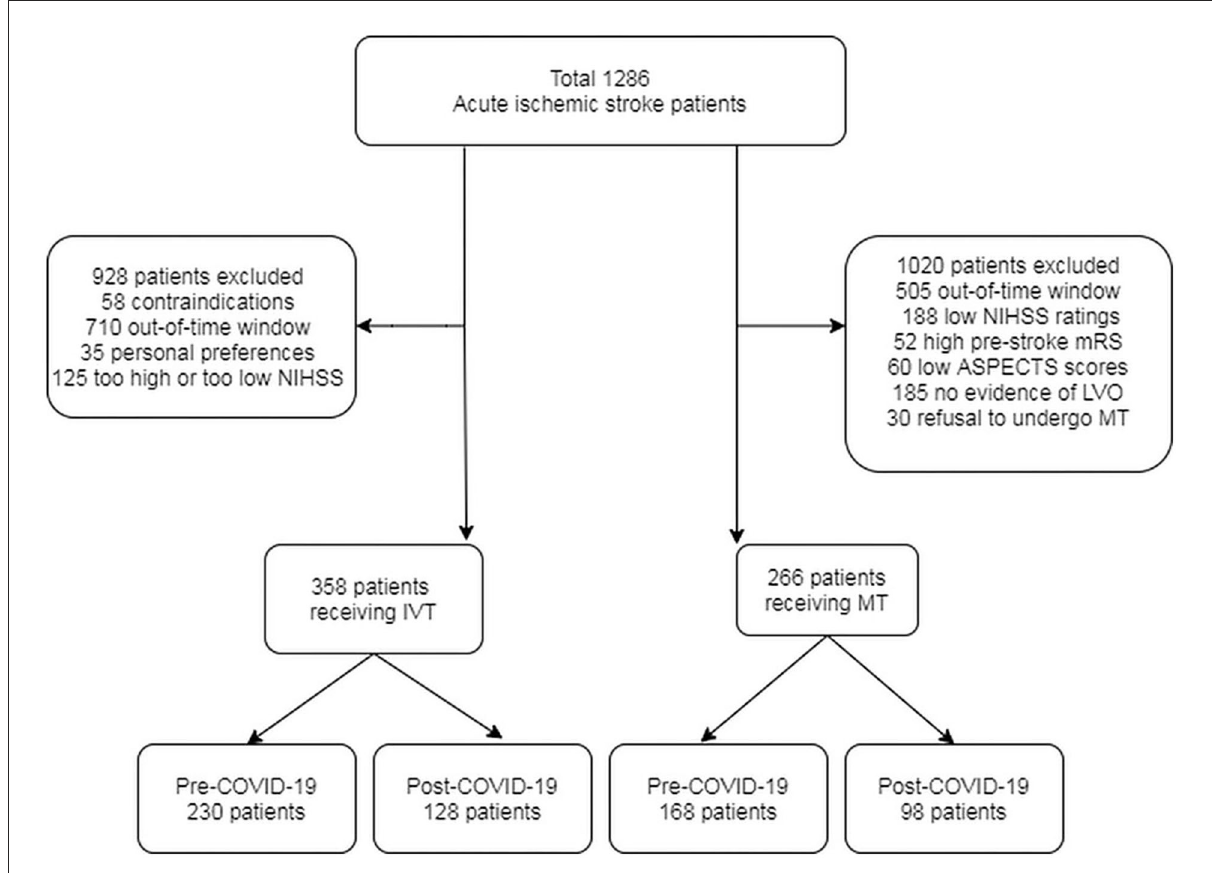
FIGURE1 The flow chart of acute stroke patients receiving IVT or MT treatment during pre- and post-COVID-19 period.